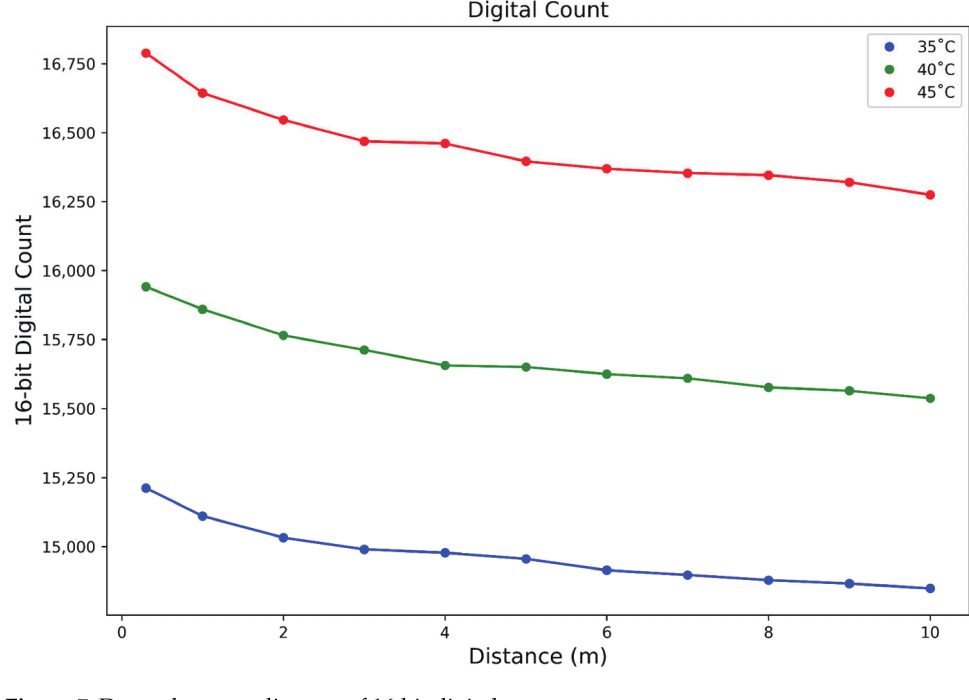
Figure 7. Dependence on distance of 16-bit digital count.